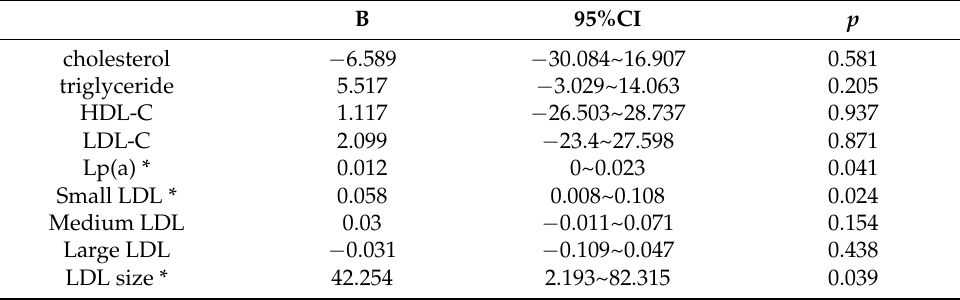
Table 3. Relationship between blood lipid concentrations and Gensini